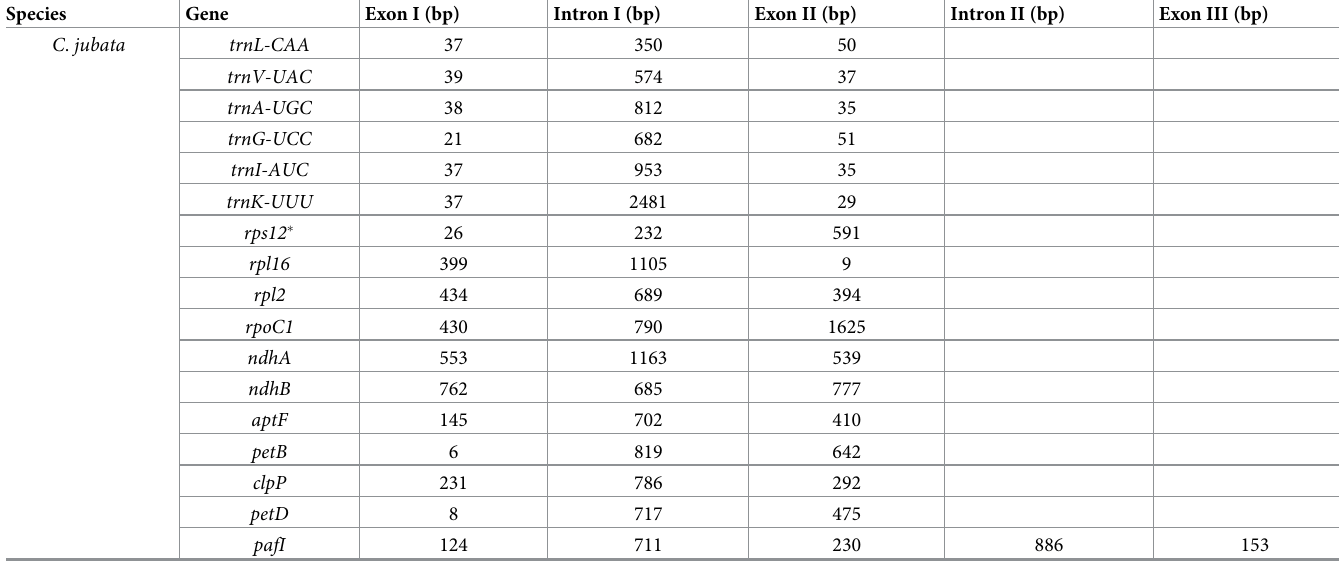
Table 3. The genes having introns in the chloroplast genome of four Caragana species and the length of the exons and introns.